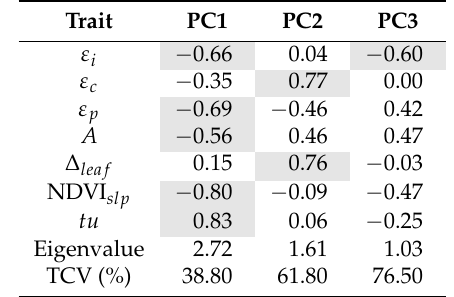
Table 4. Loadings of the first three principal components (PC) resulting from the ordination of physiological ( A , ∆ leaf ), radiation-related ( ε i , ε c , ε p ), senescence delay (NDVI slp ) and tuberization precocity ( tu ) parameters. In gray: scores > |0.5|. TCV = total cumulative variance.